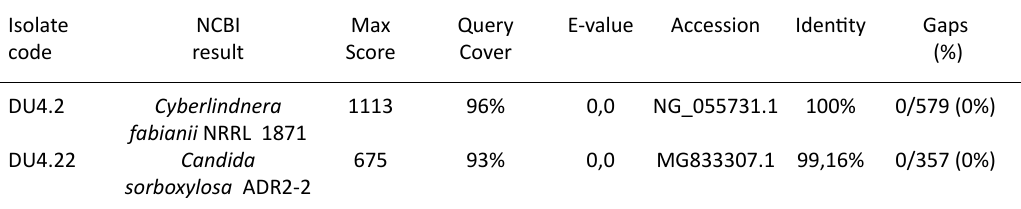
table 2. BLAST results of isolate DU4.2 and isolate DU4.22 based on D1/D2 rDNA region